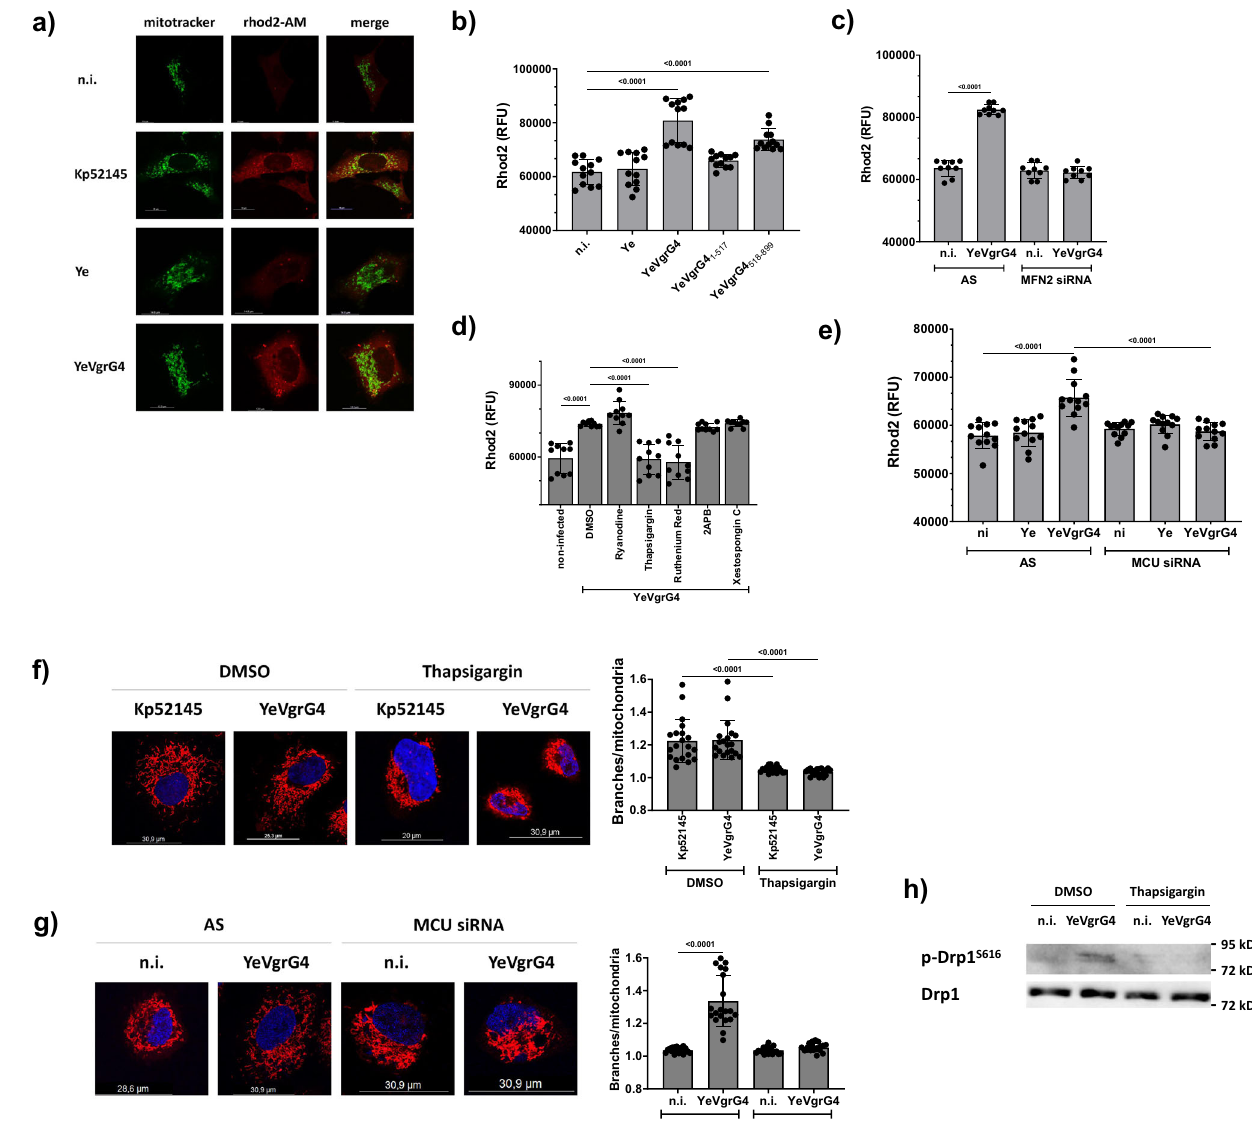
Fig. 4 | VgrG4 triggers the transfer of Ca 2+ from the ER to the mitochondria causing fragmentation. a Confocal microscopy of A549 cells treated with mito- tracker green (50 μ M, 30min before infection, in green) and then infected with Y. enterocolitica strainsfor90min,orwithKp52145for3h.After90minor3h,Rhod2 in HBSS without calcium (50 µ M, in red) was added for 30min to stain the calcium accumulation in the mitochondria. b Rhod2 fl uorescence was measured at 90min post infection as indicated before in cells infected with Y. enterocolitica strains encoding truncated versions of VgrG4.Rhod2 accumulation wasmeasured in cells knockdownforMFN2(20nM)bysiRNAtransfectionandinfectedwithYeVgrG4( c ). Cells were treated with ryanodine (100nM), thapsigargin (1 μ M), ruthenium red (100 μ M), 2APB (10 μ M) or Xestospogin C (10 μ M) or treated with vehicle control (DMSO, no inhibitor) 60min post infection. Rhod2 fl uorescence was measured as previously described ( d ). e Rhod2 fl uorescence was measured in cells transfected with siRNA for the mitochondria calcium uniporter (MCU) and infected for 2h as